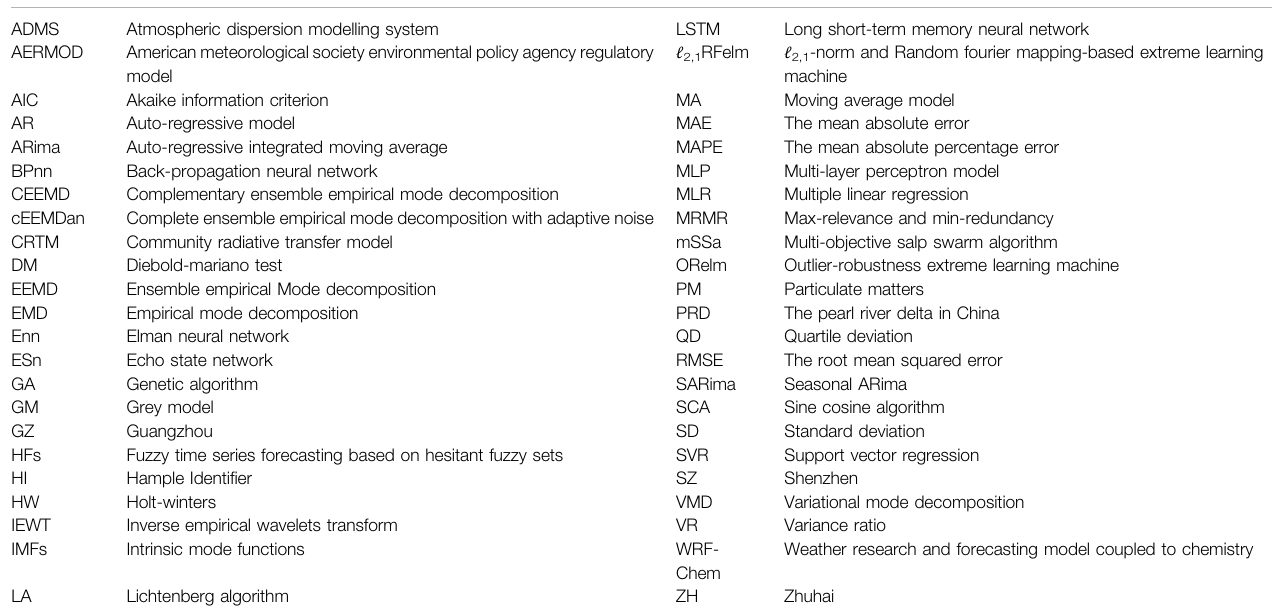
TABLE 2 | List of